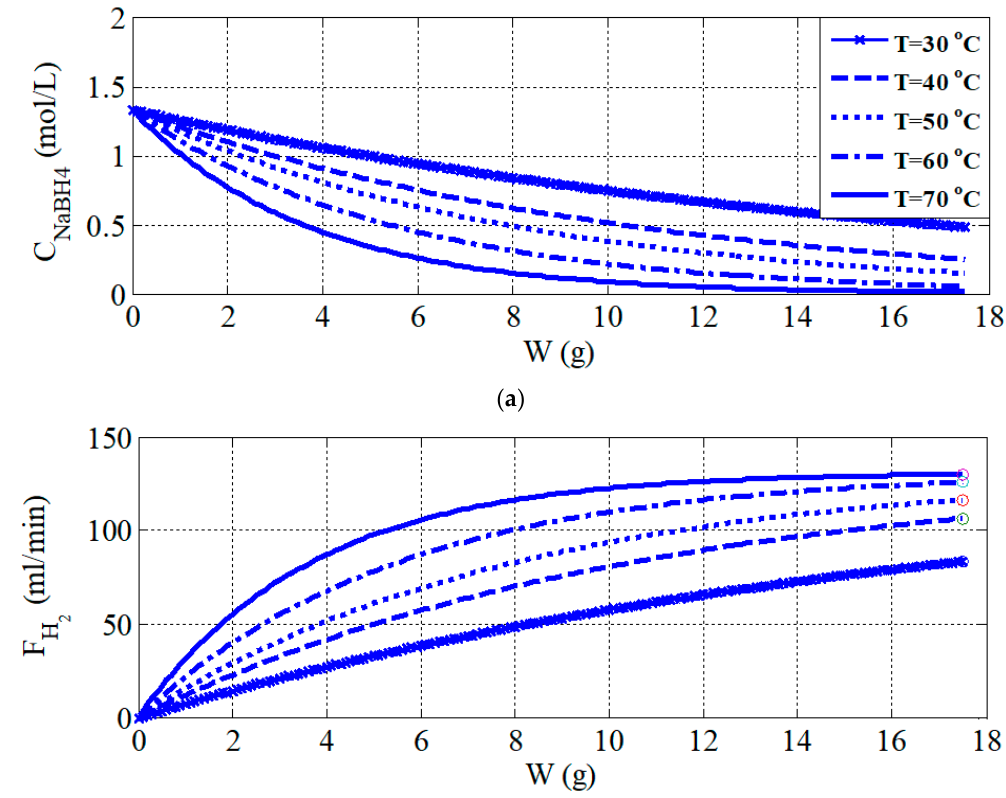
99.3%, respectively.